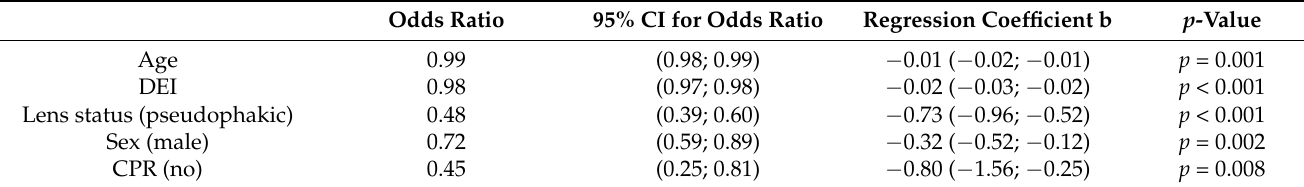
Table 8. Logistic